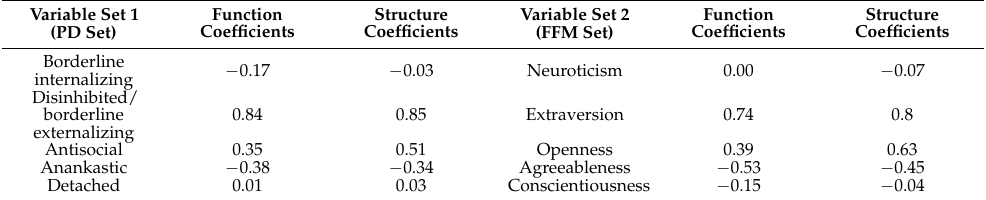
Table 3. Function coefficients and structure coefficients for the second quasi-canonical